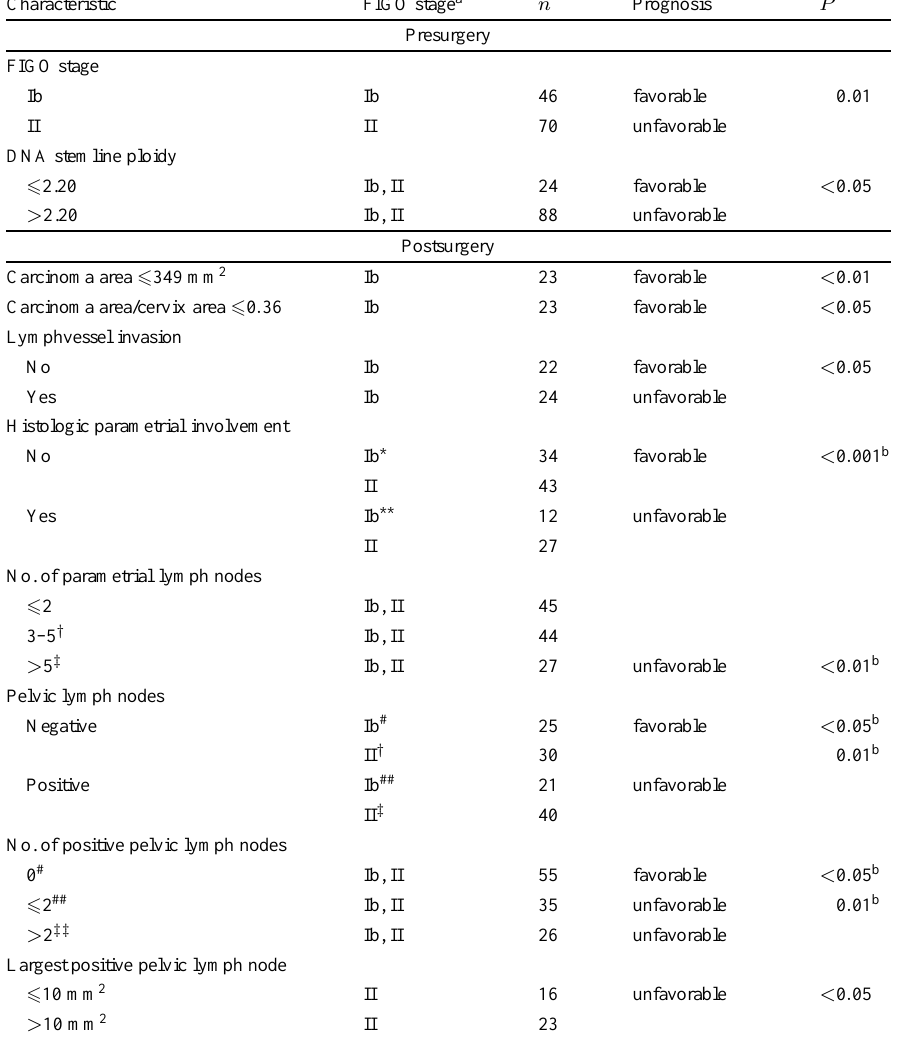
Clinicopathologic and DNA image cytometric characteristics and their relation to survival (univariate analysis)